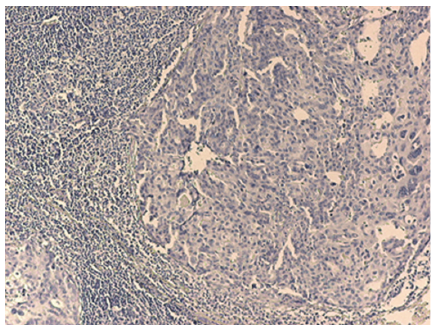
Figure 1: Malignant serous carcinoma of ovary.